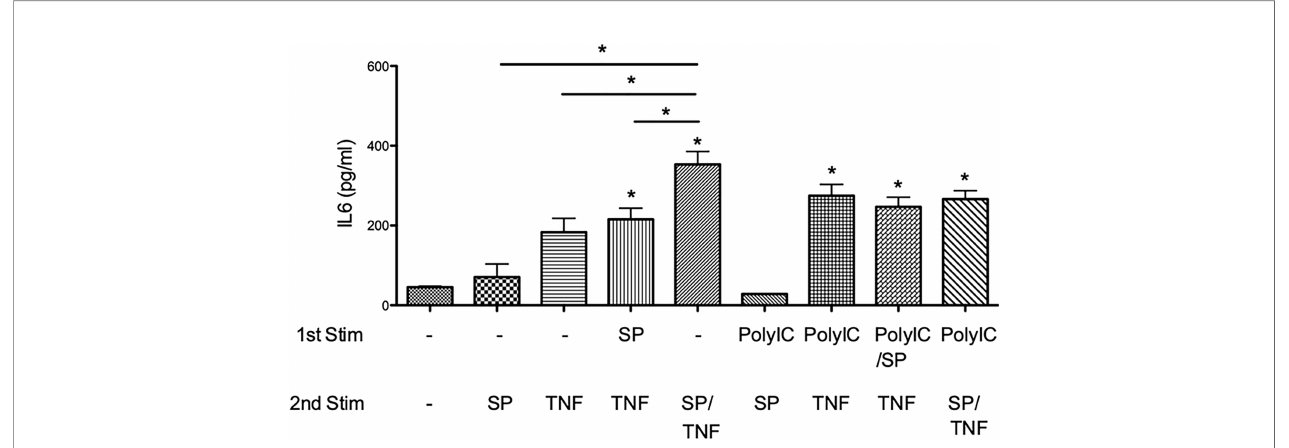
but pretreatment with of TNF a did not further increase TNF a - Figure 4 ), which may indicate that Poly (I:C) represents a speci fi c mediator to augment TNF a -induced IL6 release in human lung fi broblasts.